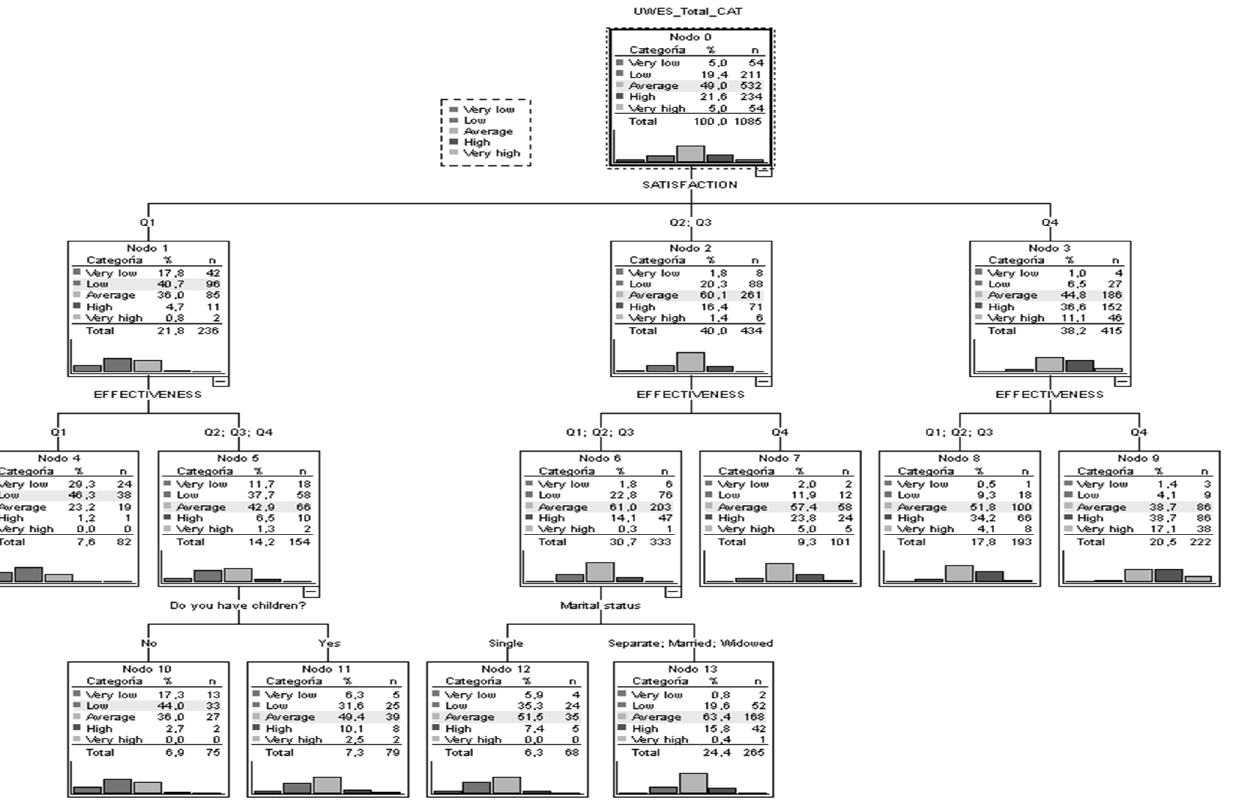
Figure 1. Classification and regression tree for UWES-9.